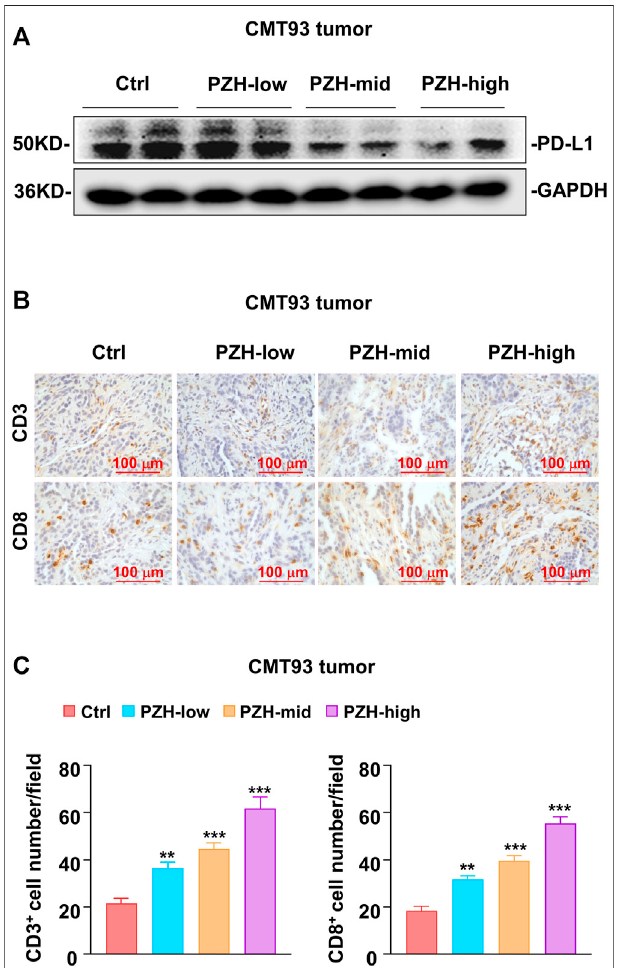
FIGURE3| PZH elevated the in fi ltration ofCD8 + T cellsin tumor tissues. (A) PD-L1 protein levels were attenuated in the tumor tissues with indicated dose PZH treatment as described in (Figures 2A,B) . (B – C) Tumor-in fi ltrating CD3 + and CD8 + T cells were elevated in PZH-treated CMT93 tumor- bearing mice ( n = 6 per group). CD3 and CD8 staining were performed by immunohistochemical analysis, and the number ofpositive cells was analyzed by Image Pro Plus 6.0 software. The results are representative of one of three experiments. Data are presented as means ± SD, ** p < 0.01, *** p < 0.001 based on one-way ANOVA.